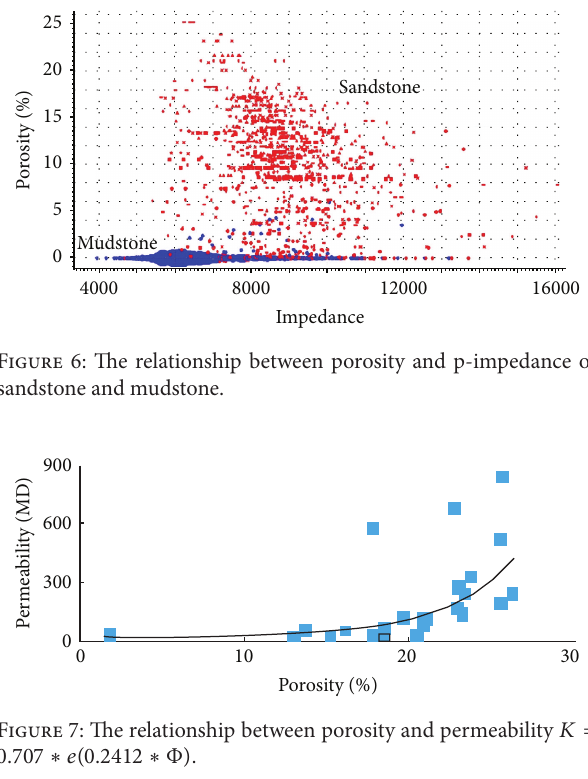
Figure 5: Porosity inversion profile.